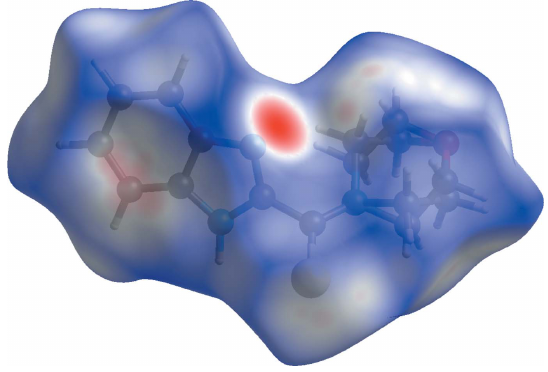
Figure 3 View of the three-dimensional Hirshfeld surface of the title compound plotted over d norm